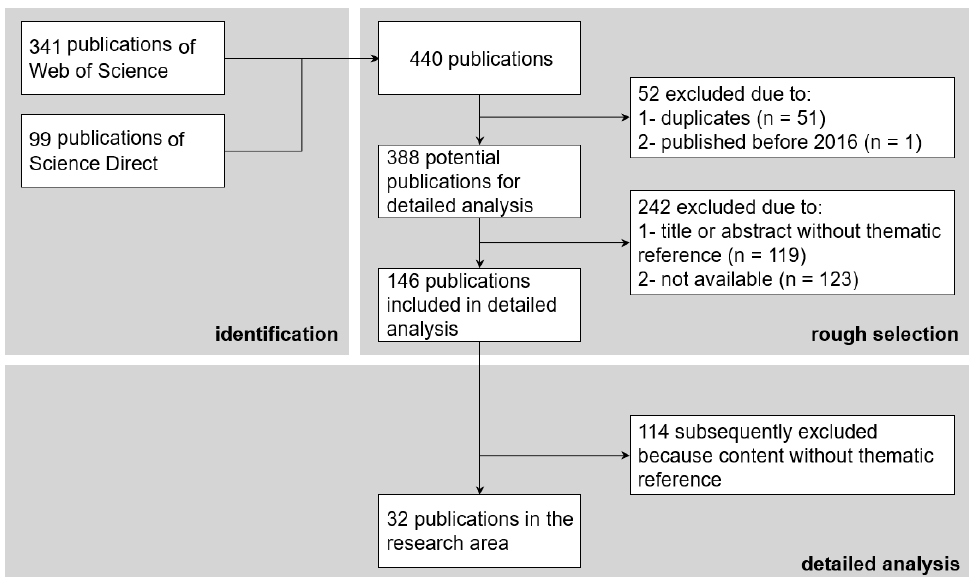
Figure 2. The literature filtering process [23] (p. 3) (greatly modified).